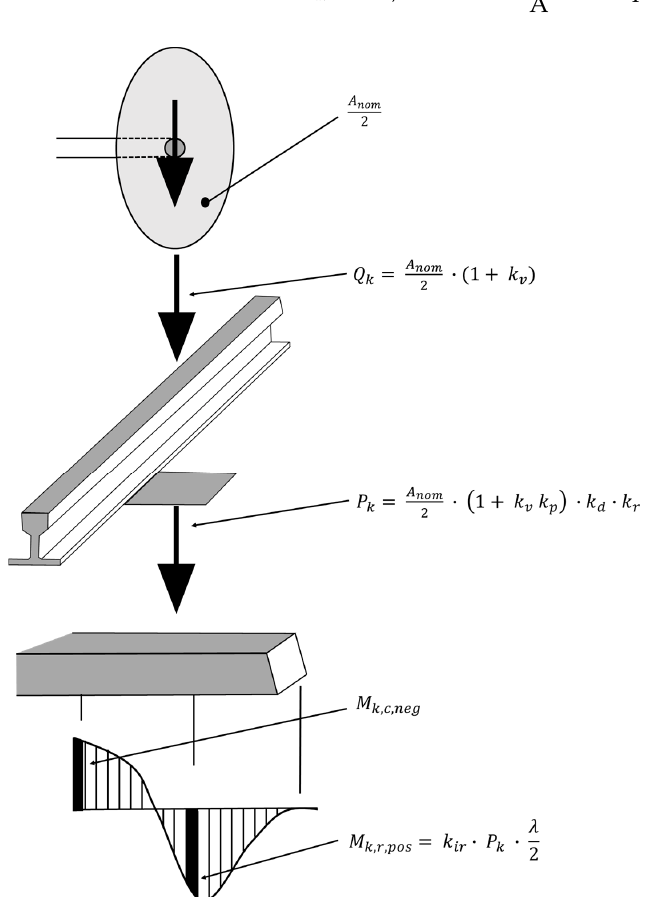
Figure 2. Load distribution for the determination of bending moments [4].